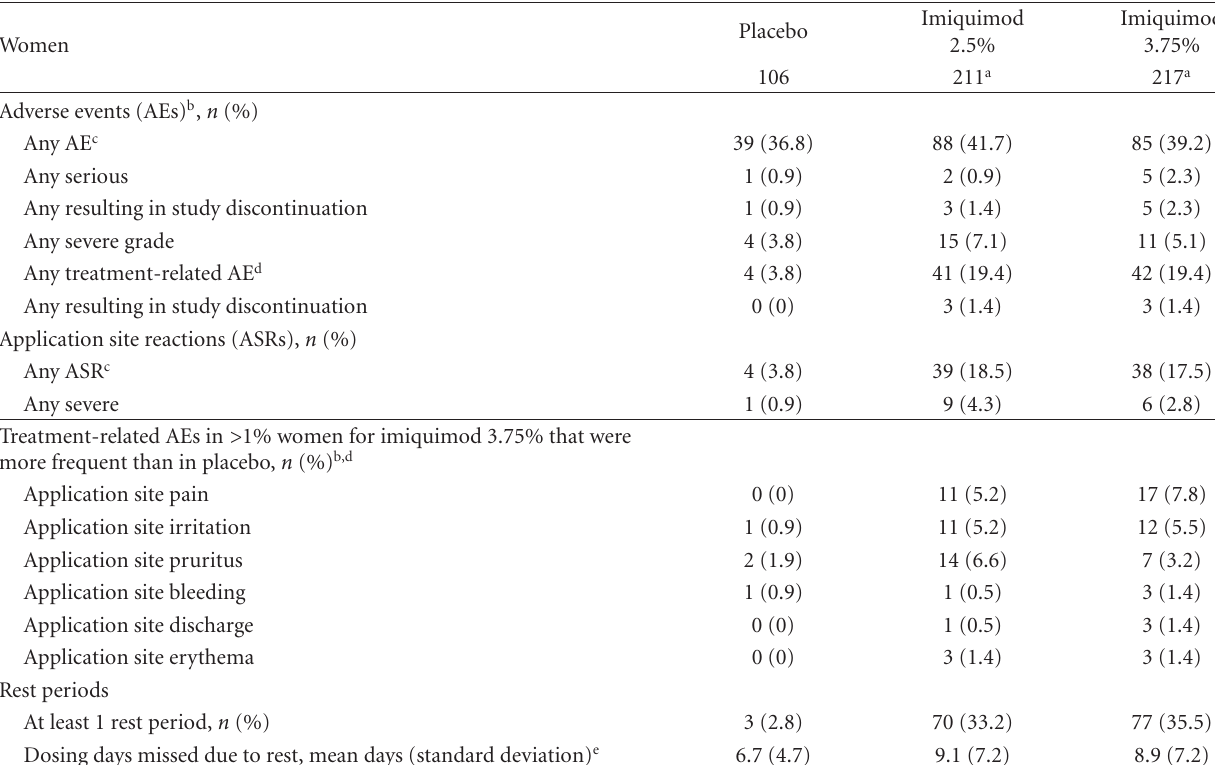
Table 3: Summary of safety by treatment group, evaluation period, all women.